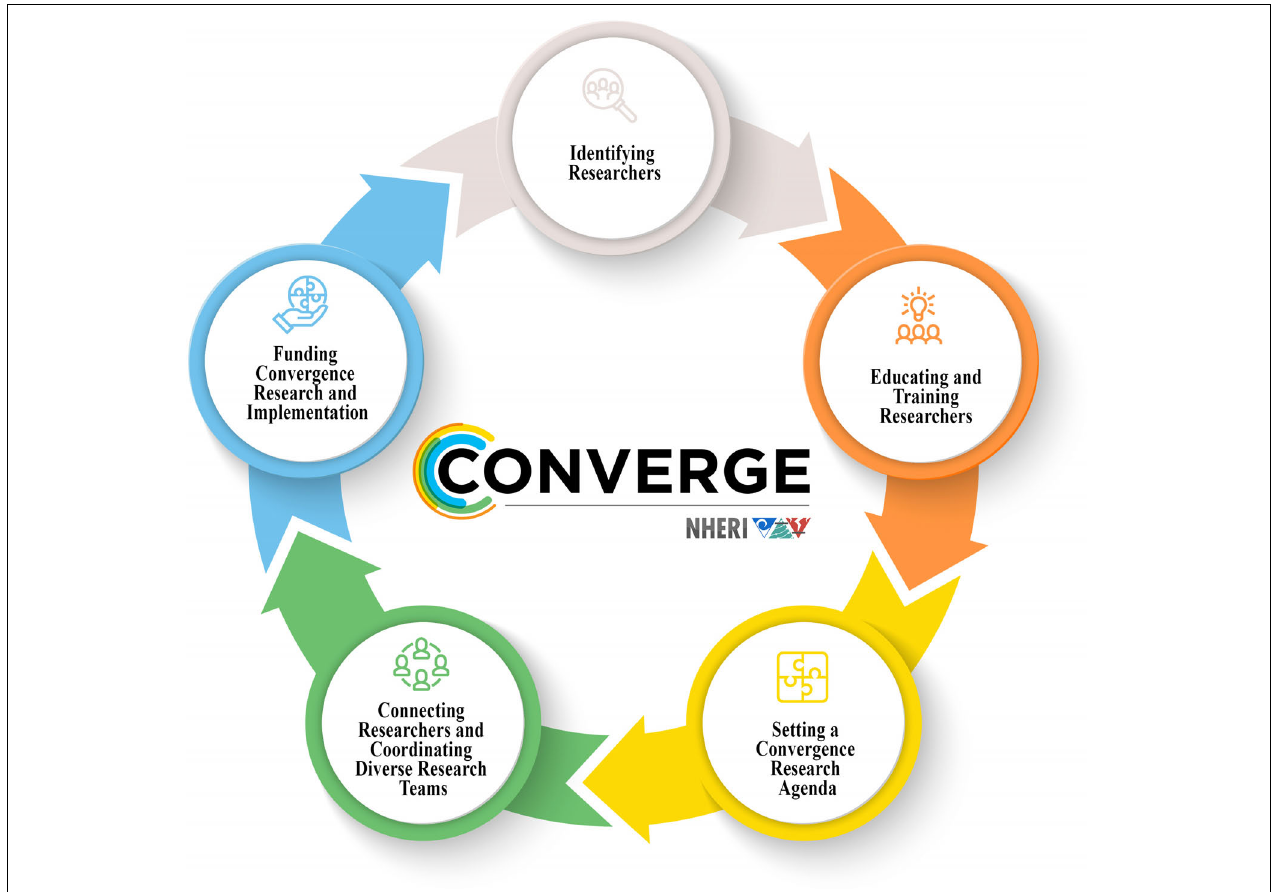
FIGURE 4 | The CONVERGE framework for supporting convergence